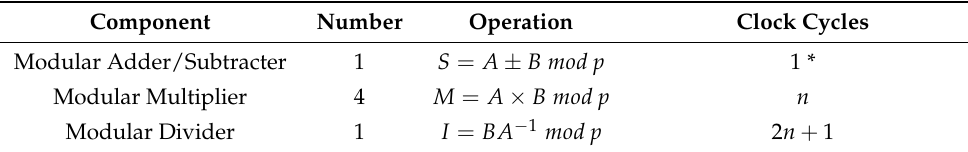
Table 3. Modular components in